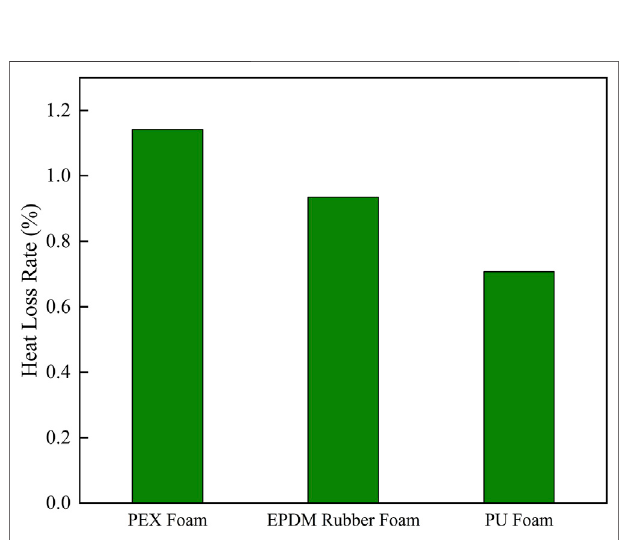
FIGURE 7 | Annual heat loss rate in different insulation materials.